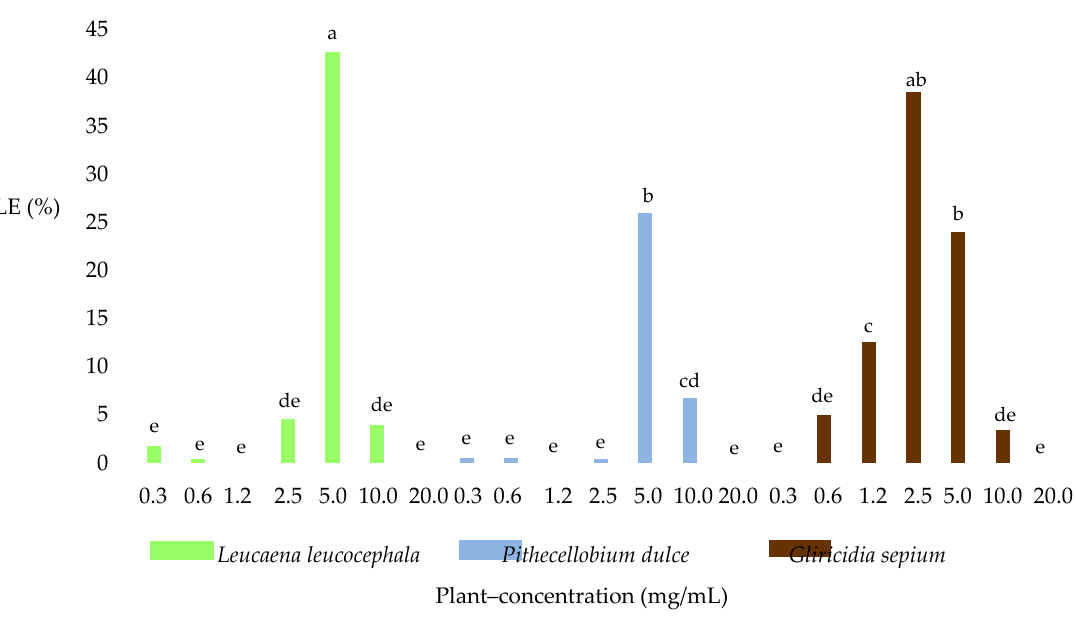
Figure 4. Effect of plant–concentration on the percentage of larvated eggs (LE). Means with a common letter are not significantly different ( p > 0.05). Fisher LSD test.